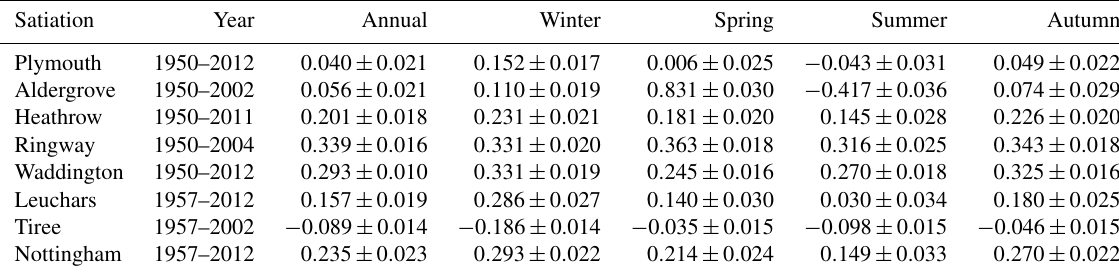
Table 2. Rate of change of visibility (in kmyear − 1 ) with their standard error at the 95% confidence interval.